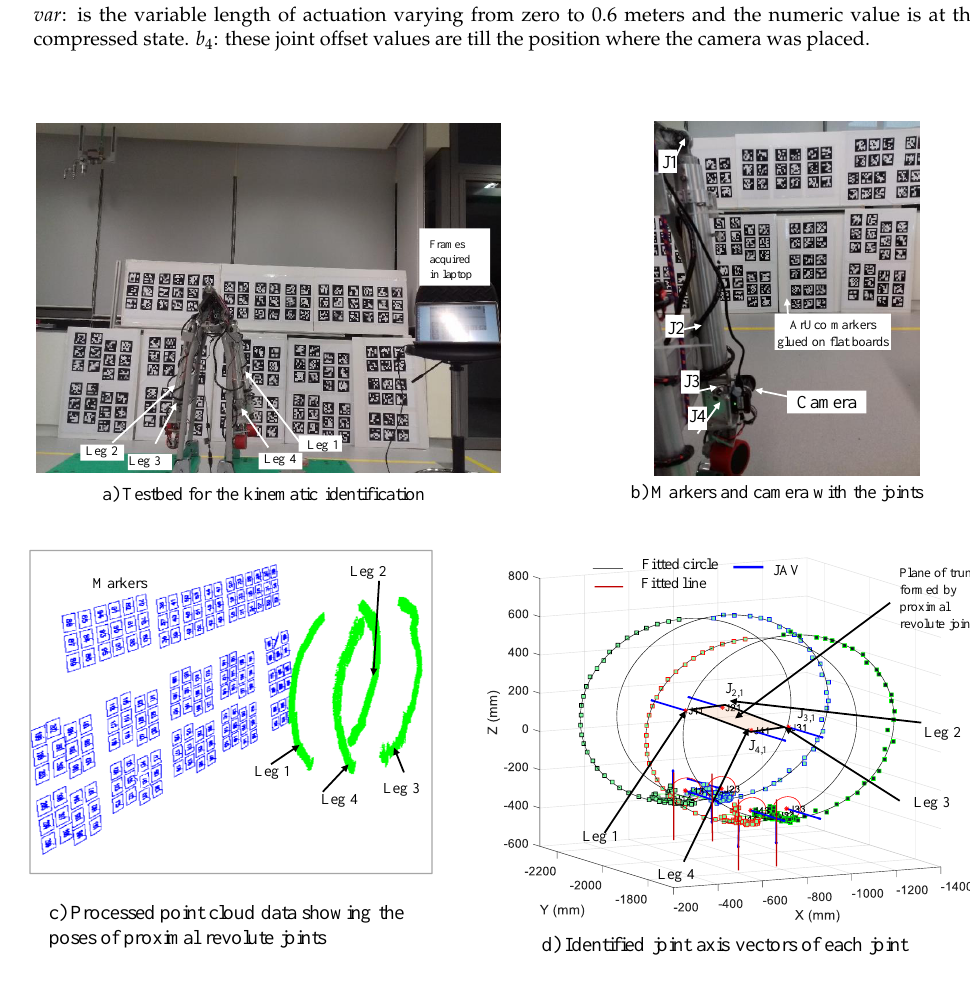
Figure 14. Setup using AruCo markers for identification and localization of